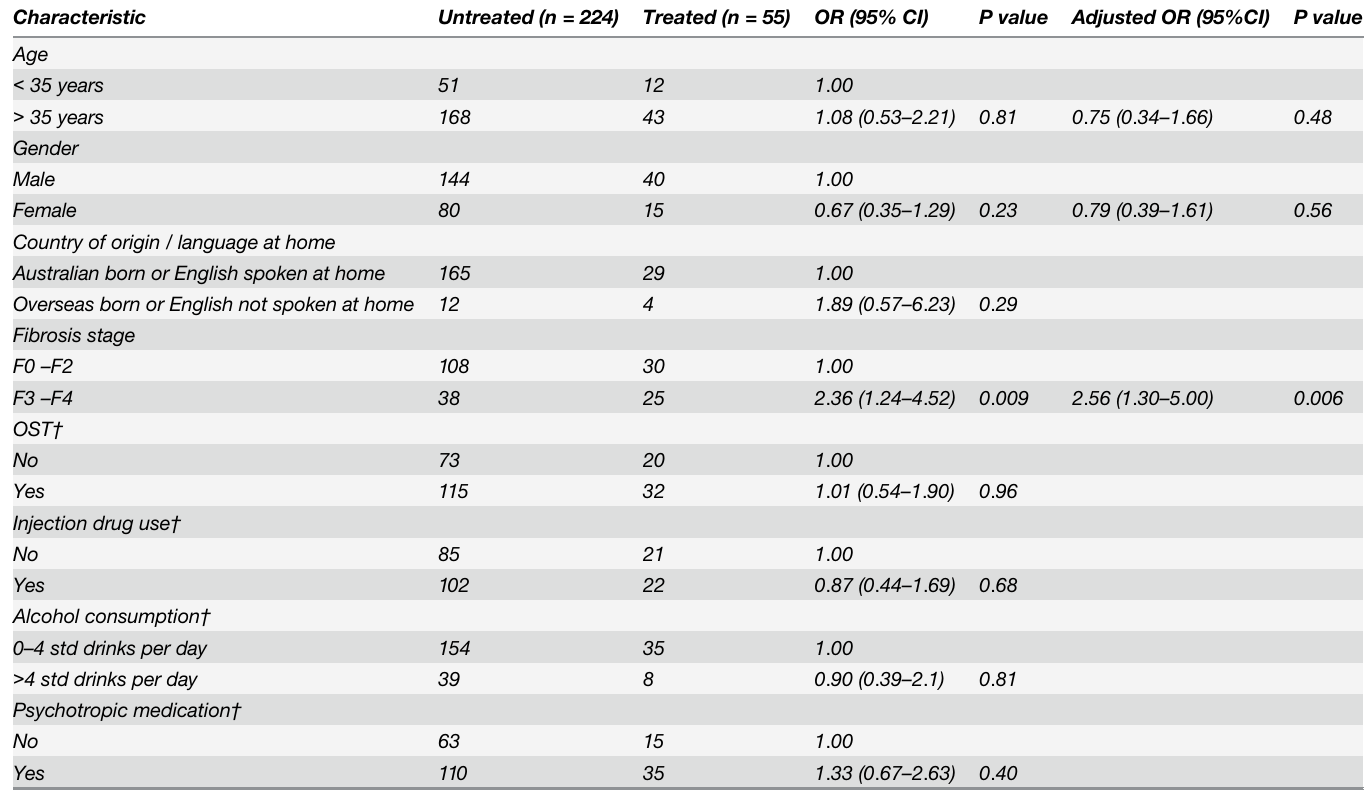
Table 2. Unadjusted and adjusted analysis of factors associated with HCV treatment uptake (N = 279).